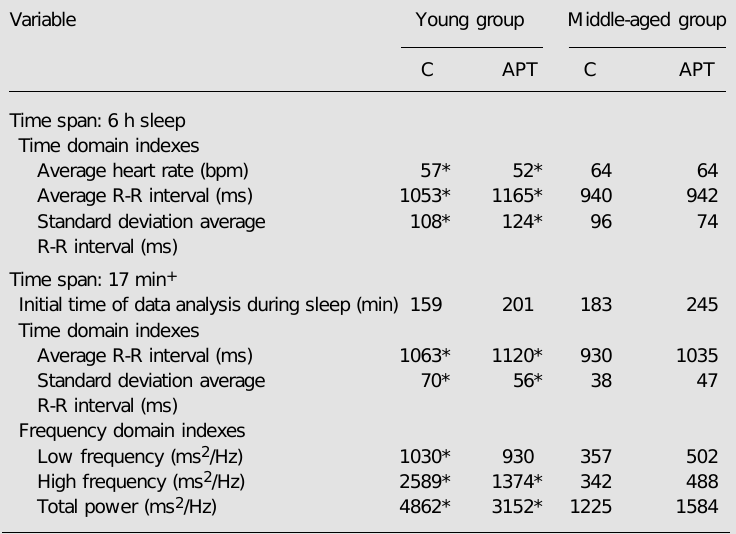
Heart rate variability was measured using time and frequency domain methods. Data are reported as medians. Young group, N = 10; middle-aged group, N = 7. + Four consecutive windows of 256 s each.